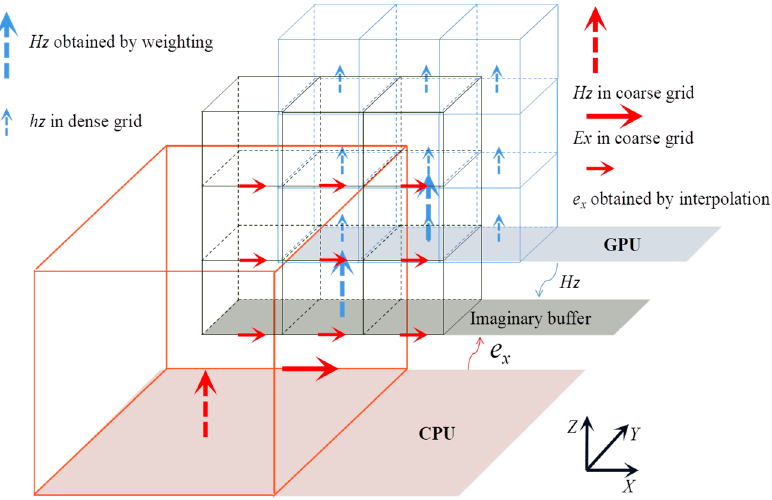
Figure 5. Data exchange between the CPU and GPU.